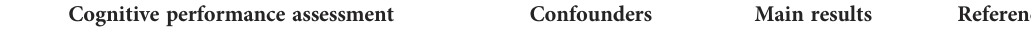
TABLE 3 Associations of neuronal and microvascular structures and function of the neurovascular coupling unit, as quanti fi ed by retinal imaging, with cognitive performance.